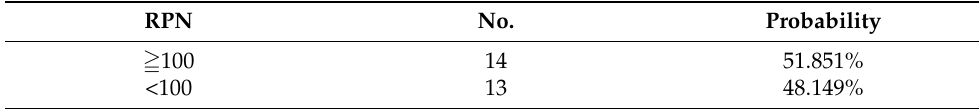
Table 10. Case 2: Probability of RPN (criterion: